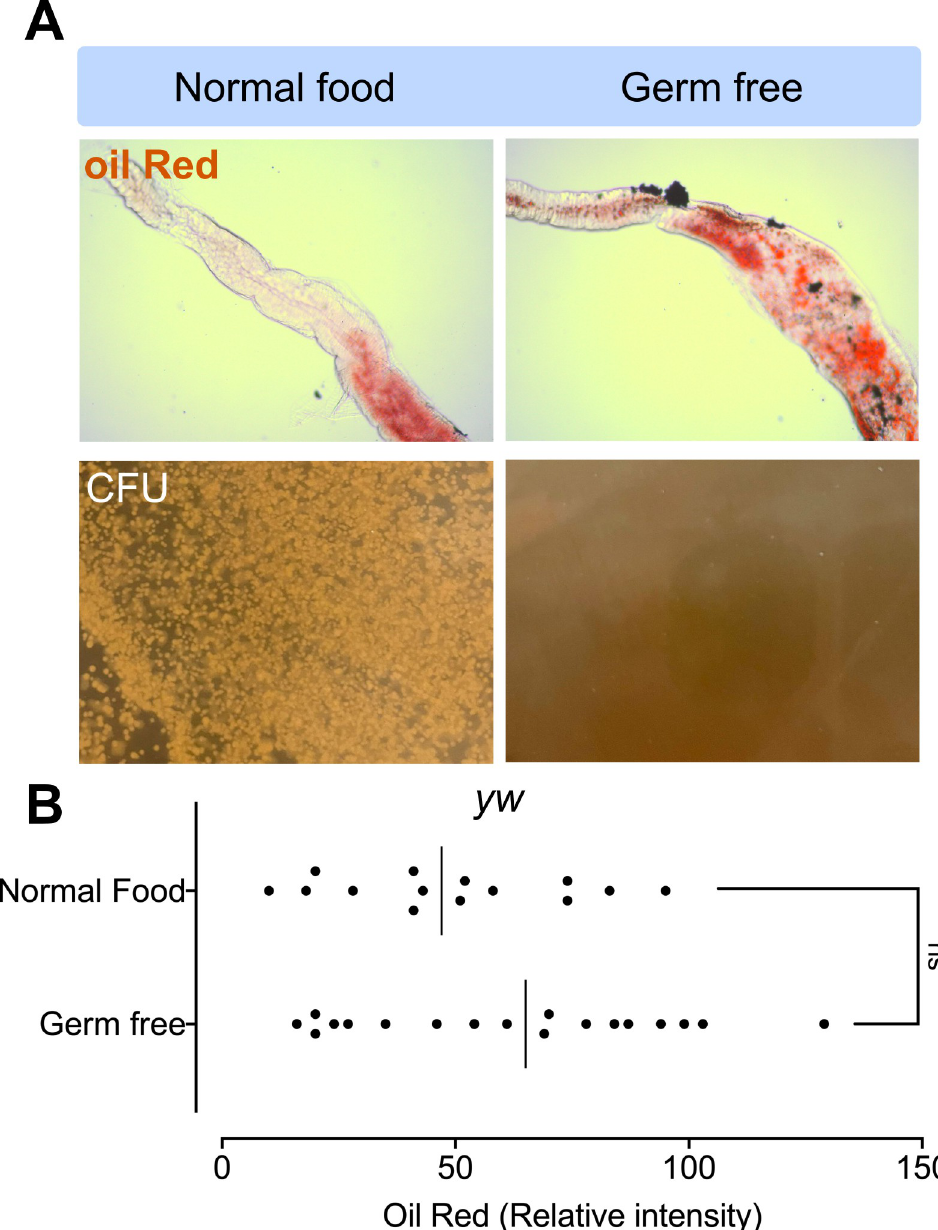
Fig 9. Axenic flies show a modest accumulation of enteric lipid levels. (A) Flies cultured in axenic conditions had on average more Oil red-stained guts. (B) Despite the observed trend this was at the margin of statistical significance (p = 0.15) as calculated using student’s t-test (ns = non-significant).